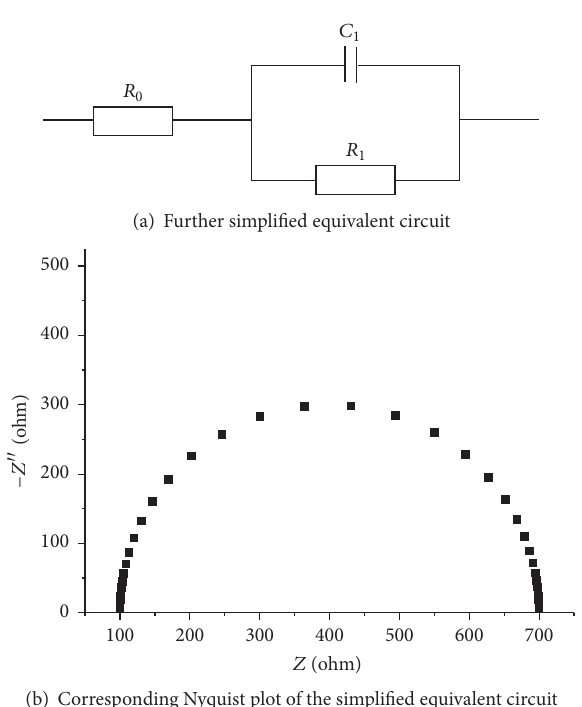
Figure 5: Further simplified equivalent circuit and its Nyquist